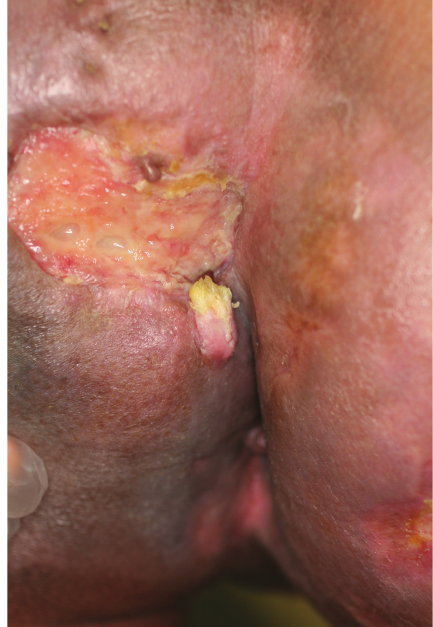
Figure 4: A washy red smooth nodule was noticed from the beneath of tumor after chemoradiation therapy. It was adjneent to the ulceration.